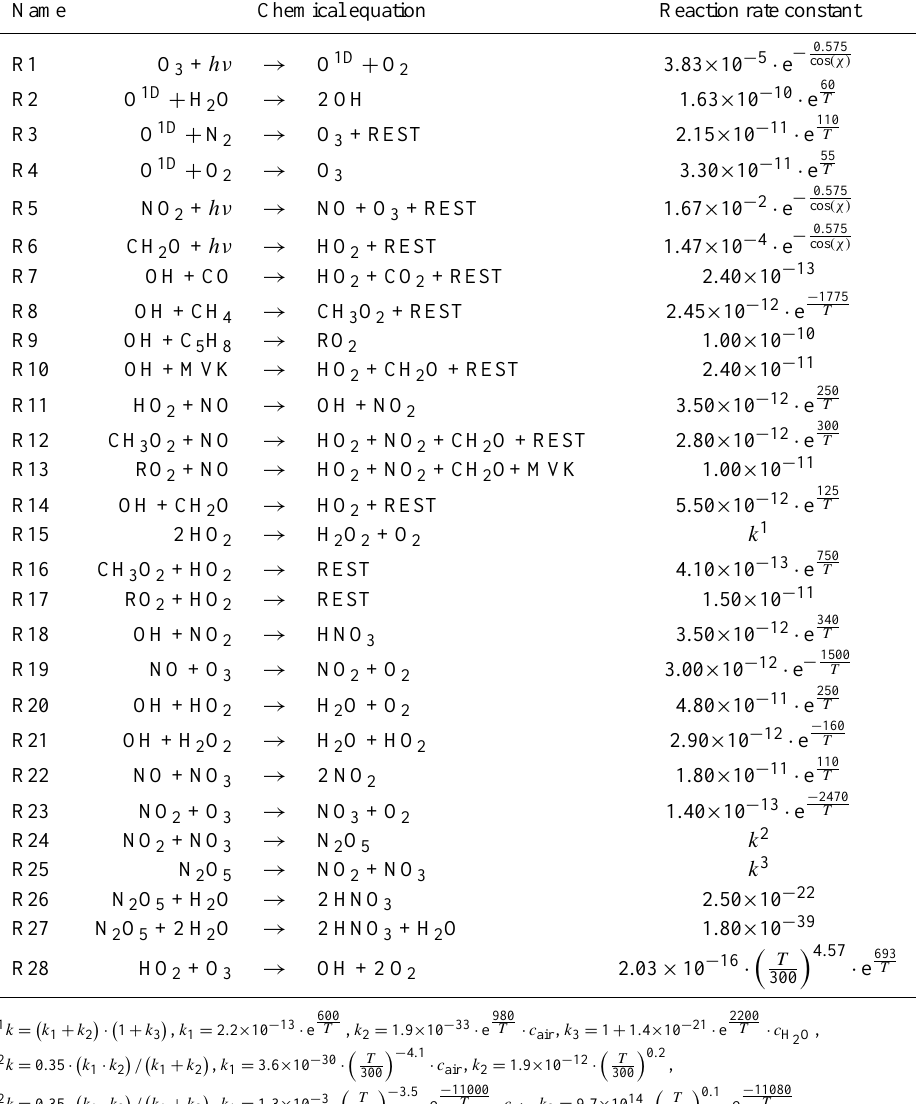
Table 1. Chemical reaction scheme solved by the MXL model, based on van Stratum et al. (2012). T is the absolute temperature in K and χ is the solar zenith angle. The unit of first-order reaction rate coefficients is s − 1 and that of second-order reaction rate coefficients is cm 3 molec − 1 s − 1 . Reactions (R15), (R24) and (R25) have more comprehensive expressions for their reaction rates 1 , 2 , 3 . For these ex- pressions, c air and c H are the concentrations in moleccm − 3 for air and H 2 O, respectively. Reactions (R1), (R5) and (R6) are photolysis 2 O reactions. MVK is the acronym of methyl vinyl ketone and REST stands for products and/or secondary fast reactions with reactants in the ambient air that are not